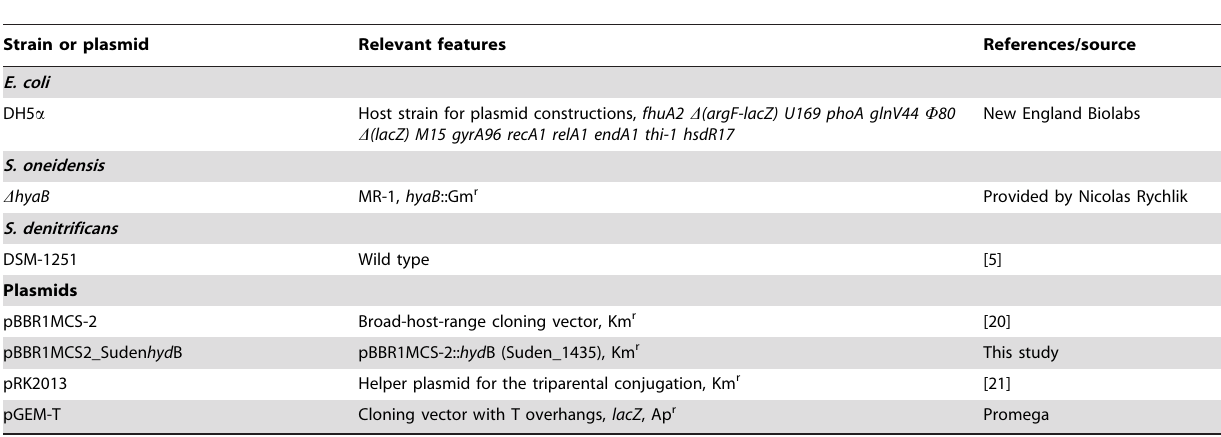
Table 1. Strains and plasmids used in this